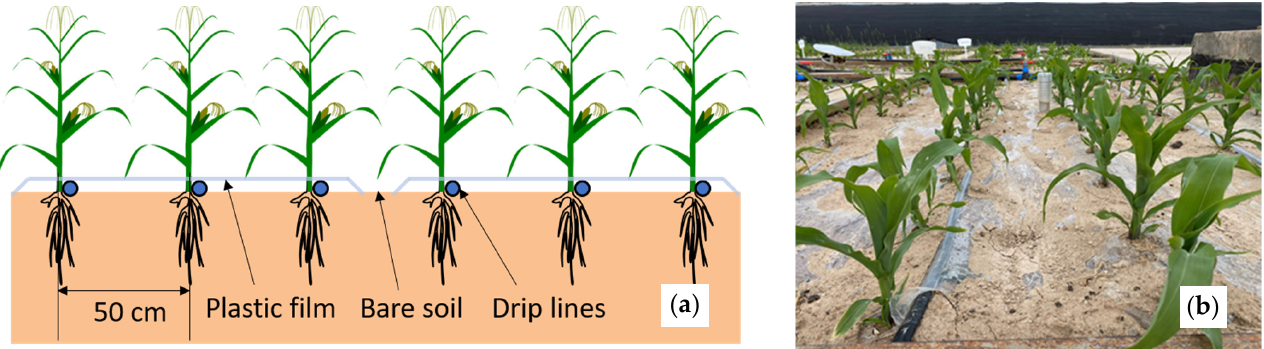
Figure 1. Schematic diagram of maize planting with drip irrigation under mulch ( a ) and photo ( b ).